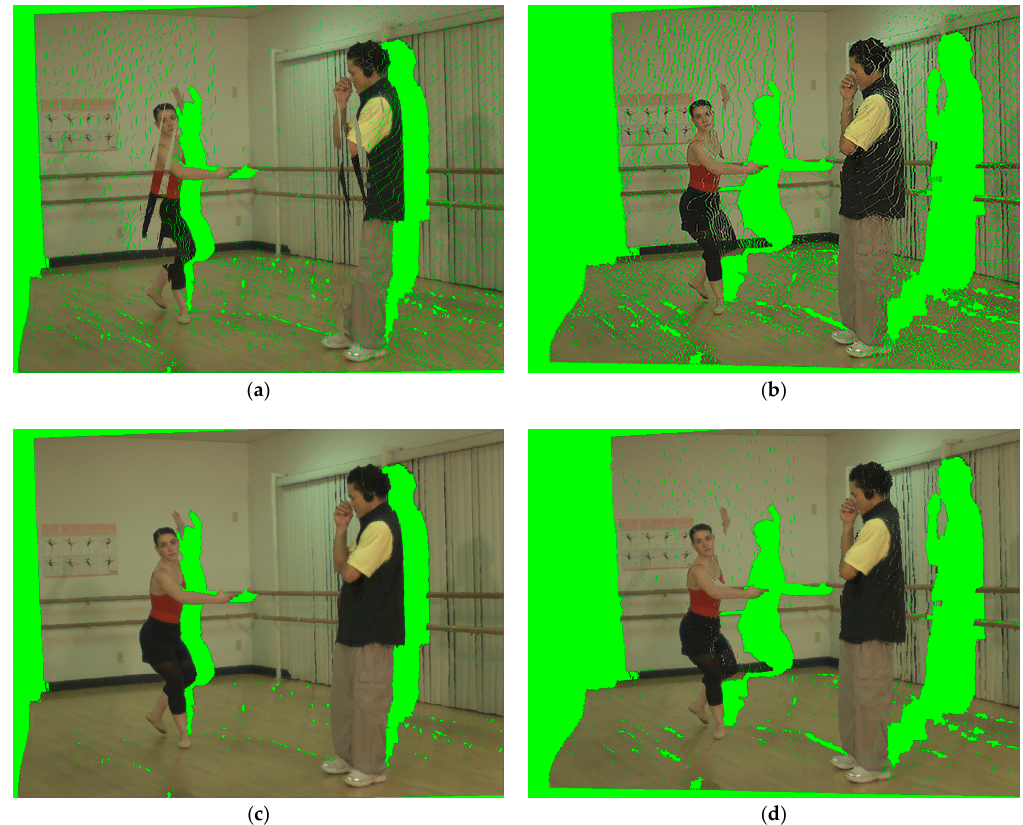
Figure 10. Visual quality comparison of 3D warping: ( a ) Synthesized result of the original 3D warping for BA54; ( b ) synthesized result of the original 3D warping for BA52; ( c ) synthesized result of the modified 3D warping for BA54; and ( d ) synthesized result of the modified 3D warping for BA52.